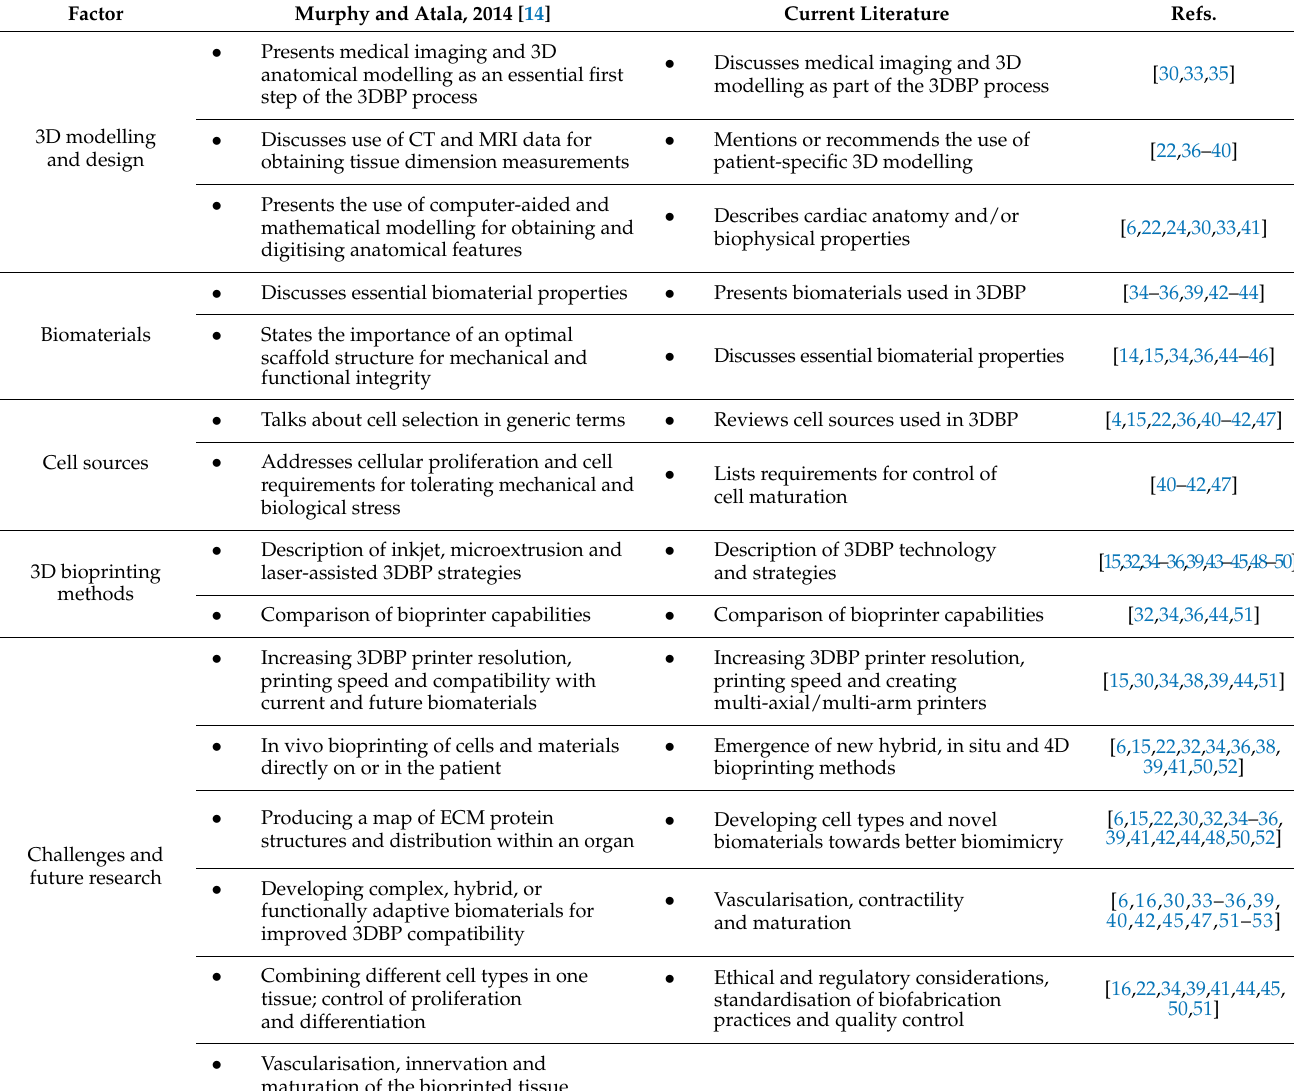
Table 1. Summary of important factors and challenges in 3D bioprinting as reported by Murphy and Atala in 2014 [14] and as discussed in current reviews and articles. Current Literature